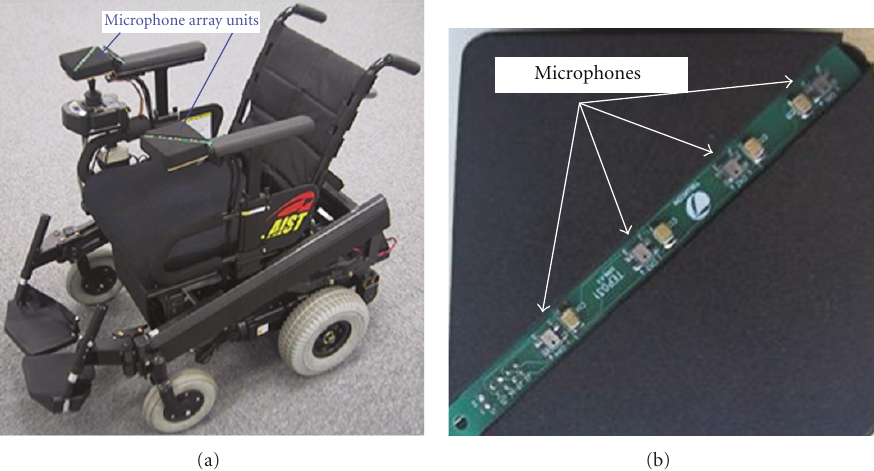
Figure 1: A wheelchair with the developed microphone array system. (a) The developed wheelchair. (b)The microphone array